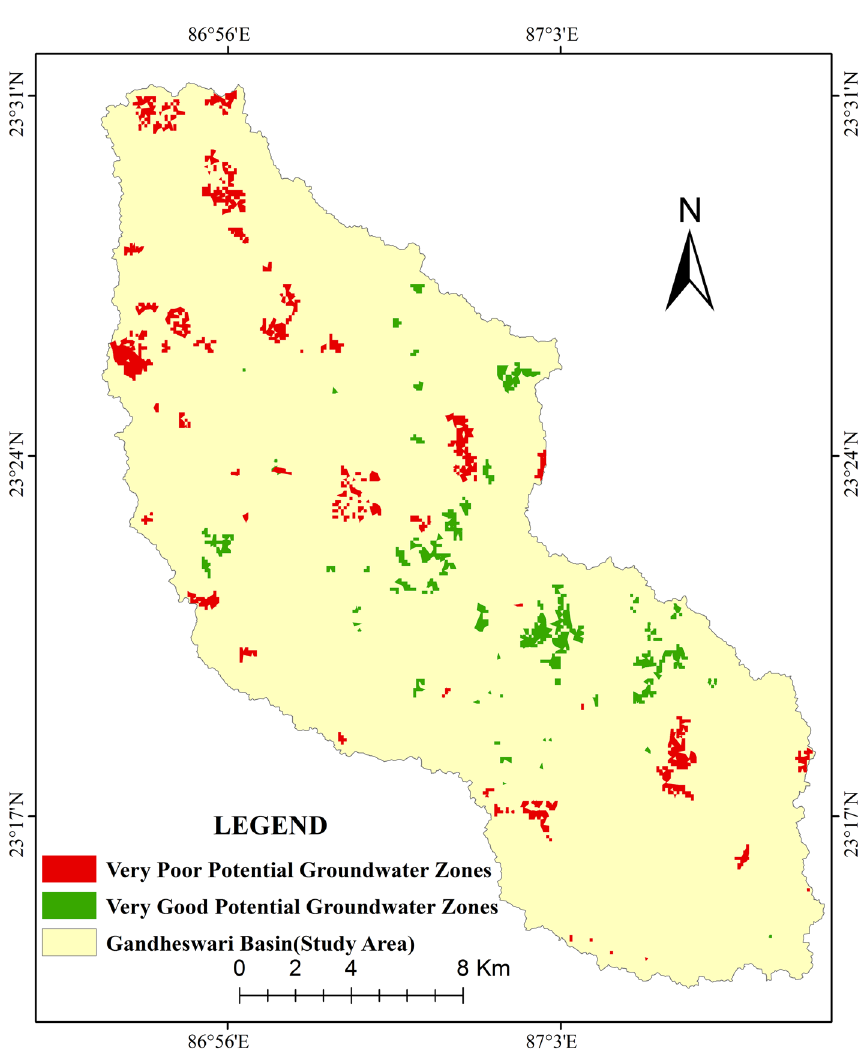
Fig. 5 Final very good and